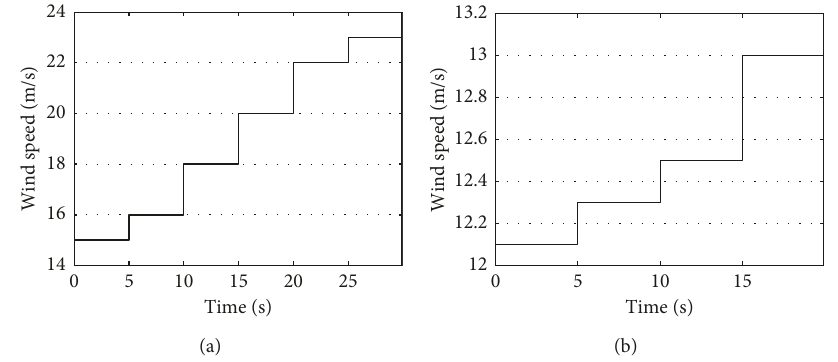
Figure 16: Step-change wind